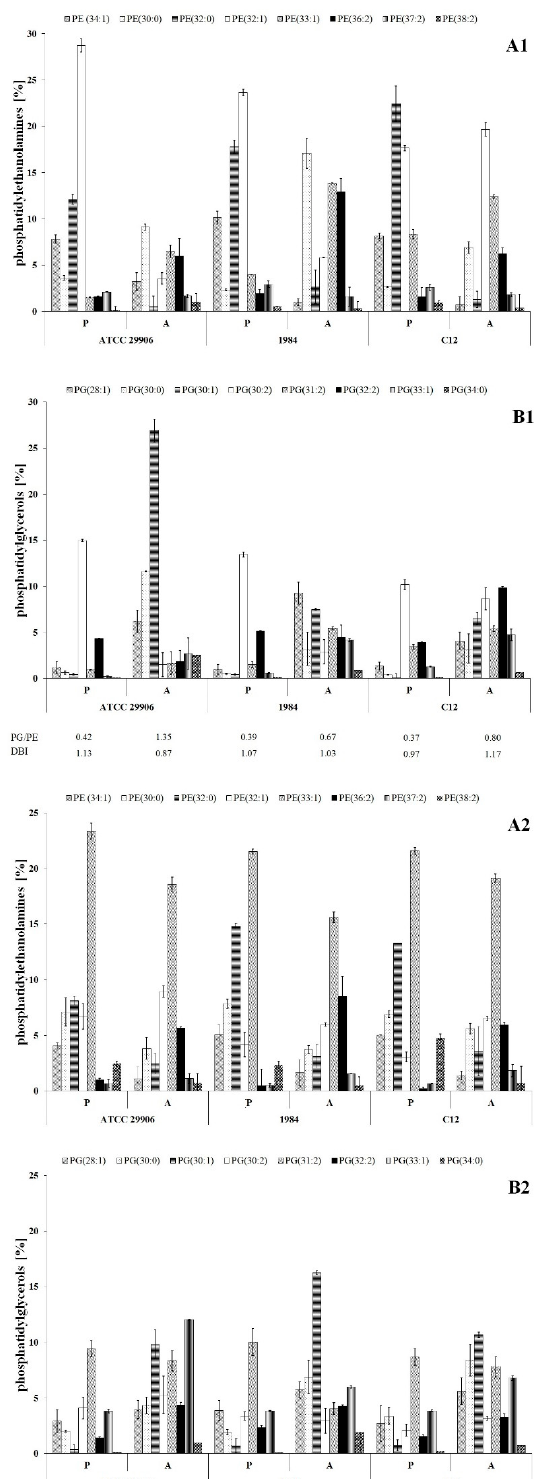
Figure 3. Relative abundances of phosphatidylethanolamines ( A1 , A2 ) and phosphatidylglycerols ( B1 , B2 ) isolated from both the outer and the inner membranes of 6 h ( A1 , B1 ) and 24 h ( A2 , B2 ) planktonic and adherent cells of P. mirabilis ATCC 29906, 1984 and C12.